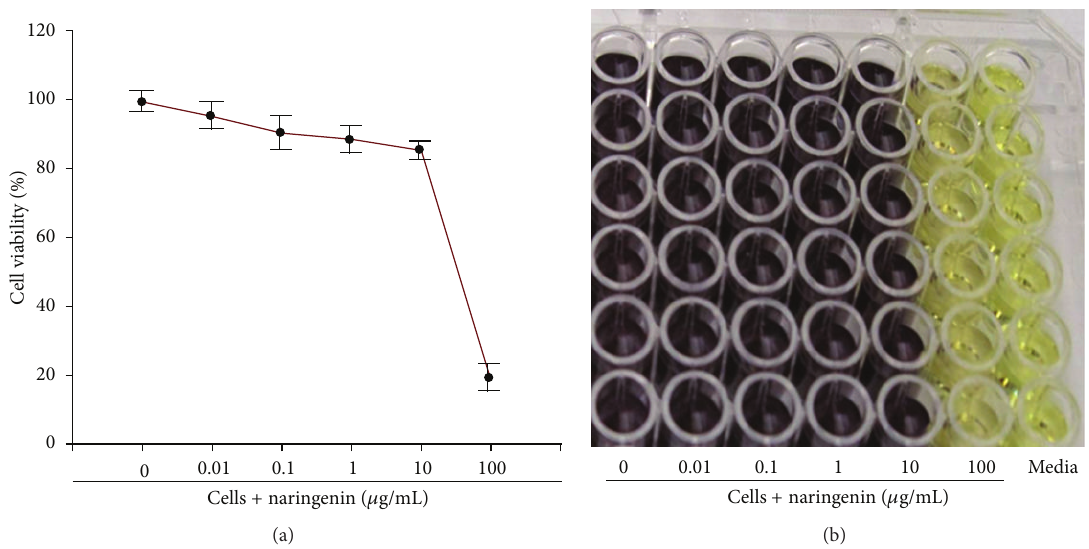
Figure 2: Naringenin toxicity to mouse J774 macrophages is concentration dependent. Macrophages were seeded in a 96-well plate at a density of 10 5 cells/well/50 𝜇 L in the presence or absence of naringenin in concentrations ranging from 0.1 to 100 𝜇 g/mL. The CellTiter 96 Cell Proliferation Assay kit was used to determine cell viability. Absorbance was read at 570 nm and the percentage of cell viability was calculated by using the optical density readings compared to normal cells (a). A representative plate before the absorbance readings where dark purple and yellow wells are depictions of live and dead cells, respectively (b). The data are representative of three separate